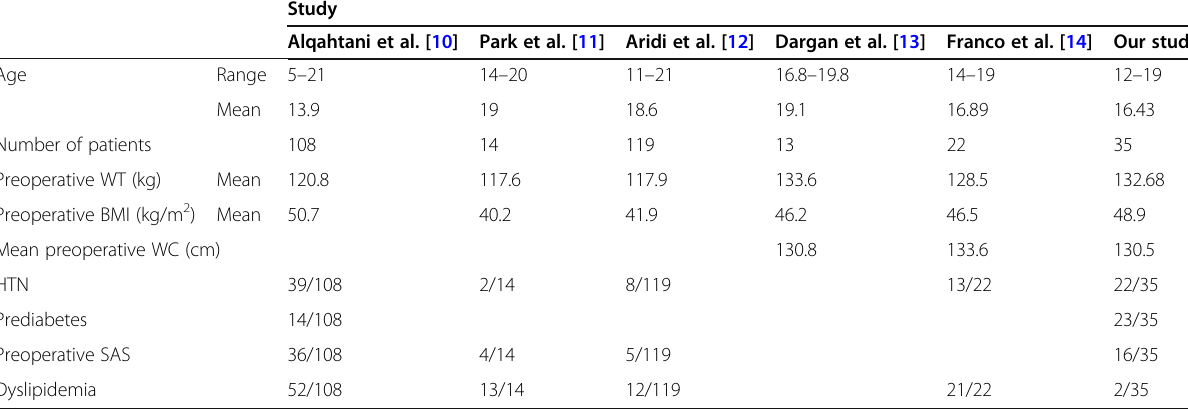
Table 3 The ages, numbers, and preoperative parameters of the reported adolescent obese patients